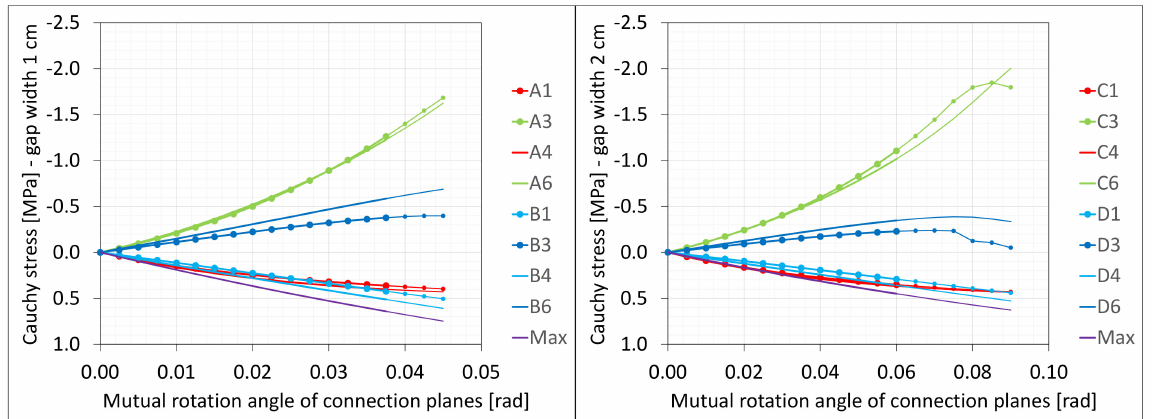
Figure 9. Equilibrium paths for stresses σ z in selected nodes. The gap width is equal to 1.0 cm, left graphic, and 2.0 cm, right graphic. Parts of charts with non-physical deformations are displayed with thin lines.